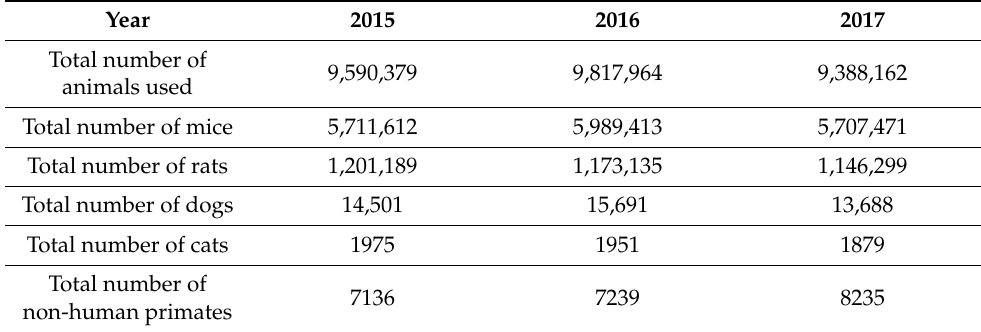
Table 2. Total Number of Animals Used in Experiments in the EU in the Period 2015–2017 [27].